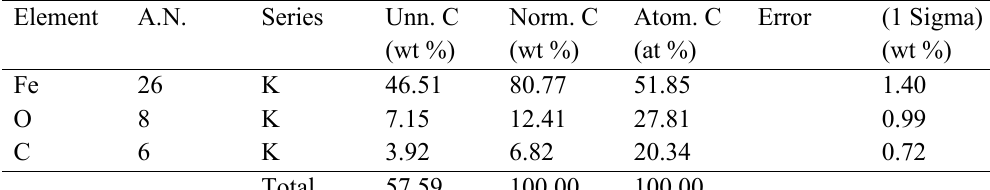
Table 1: Elemental composition of the sample by EDS Table 1. Elemental composition of the sample by